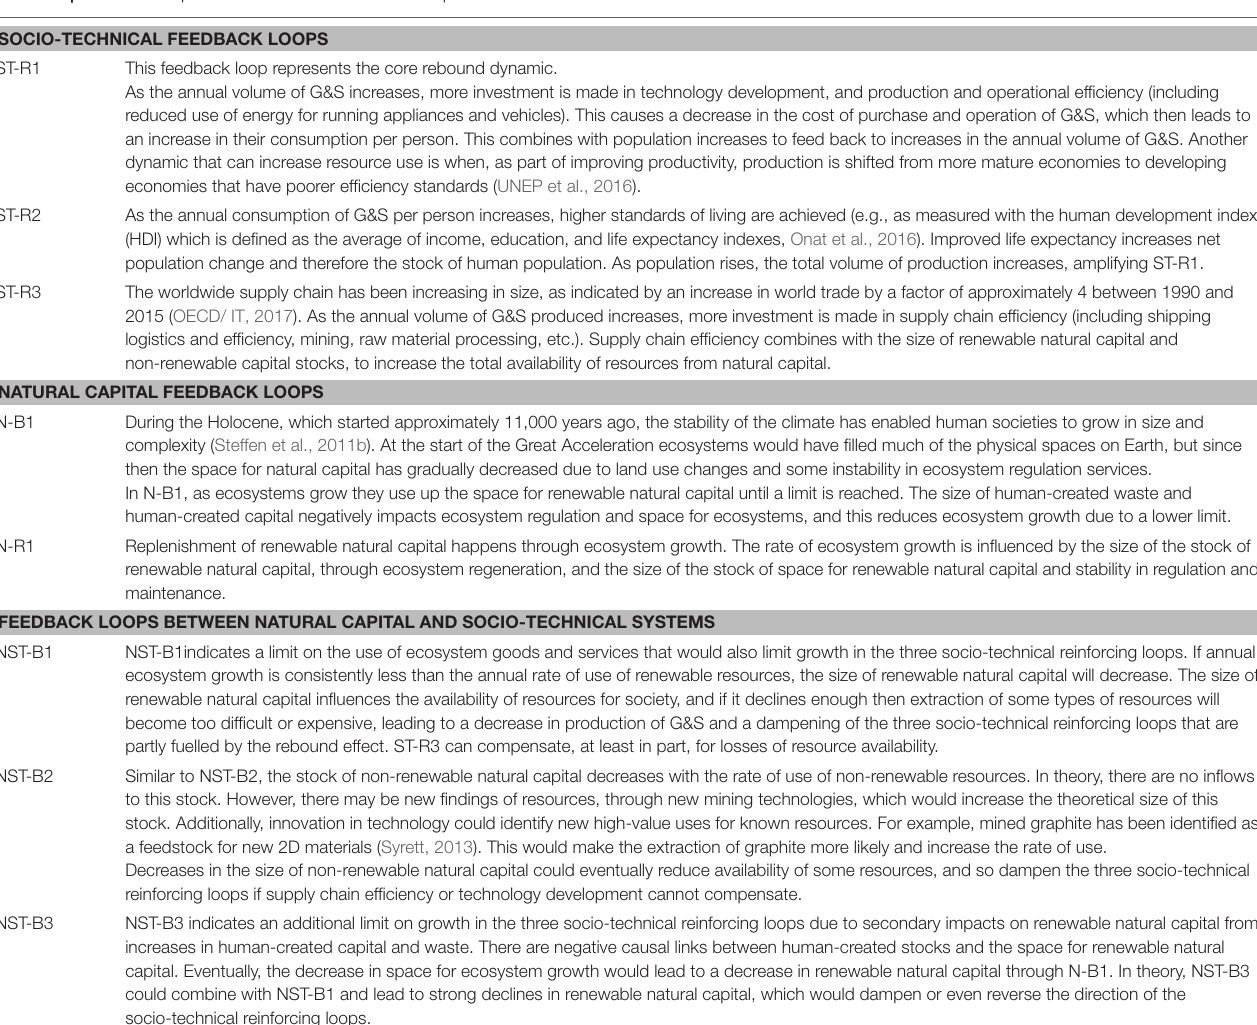
TABLE 3 | Feedback loops in the model and their causal